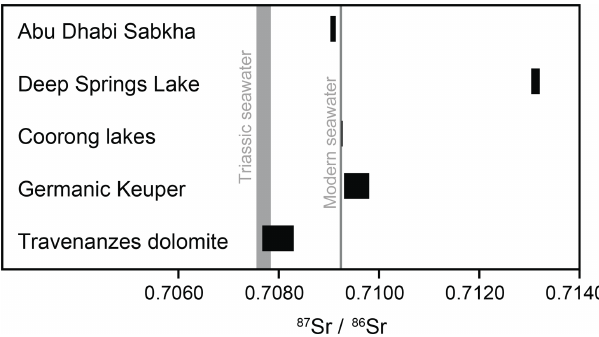
Figure 12. Sr-isotope values ( 87 Sr / 86 Sr ratios) in dolomites from different modern environments (Abu Dhabi Sabkha, Deep Springs Lake, Coorong lakes) and from ancient environments (Germanic Keuper – Weser Fm. and Arnstadt Fm.; Travenanzes Fm. of the Dolomites, southern Alps) in comparison with modern seawater (DePaolo and Ingram, 1985) and Triassic seawater (Korte et al.,